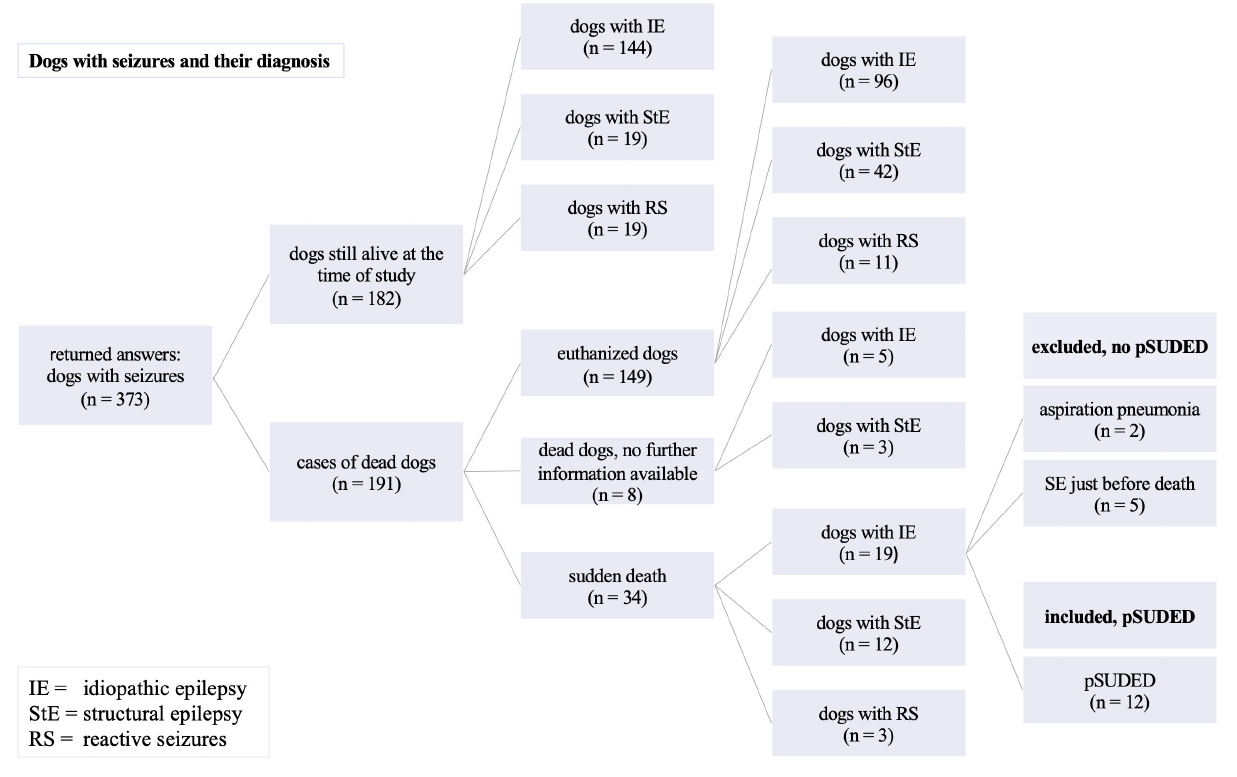
FIGURE 4 | Overview of euthanized dogs with